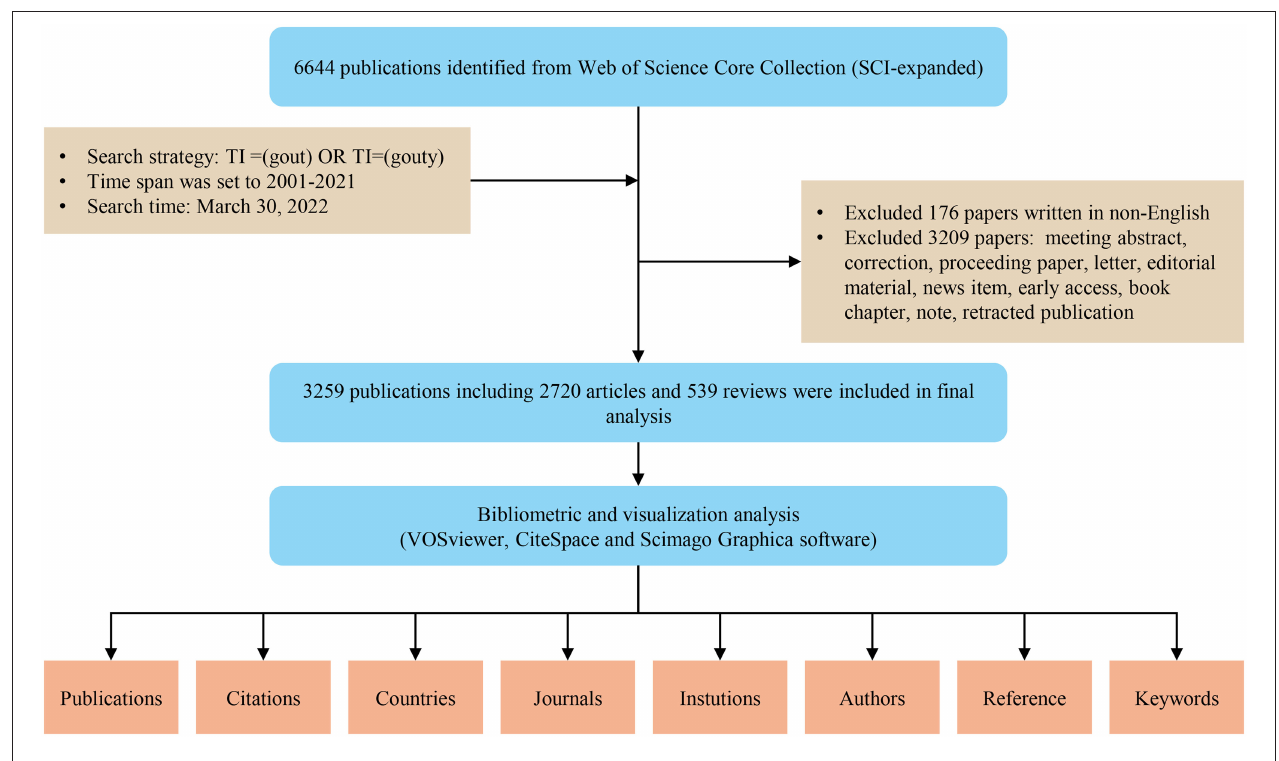
FIGURE 1 | Flowchart of the literature search, screening, and